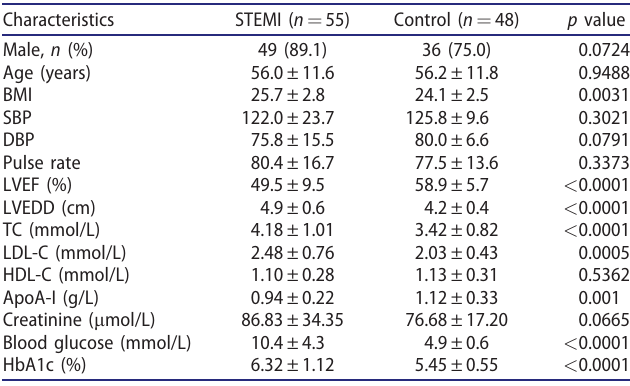
Table 1. Clinical characteristics of patients in the STEMI and control group. Characteristics